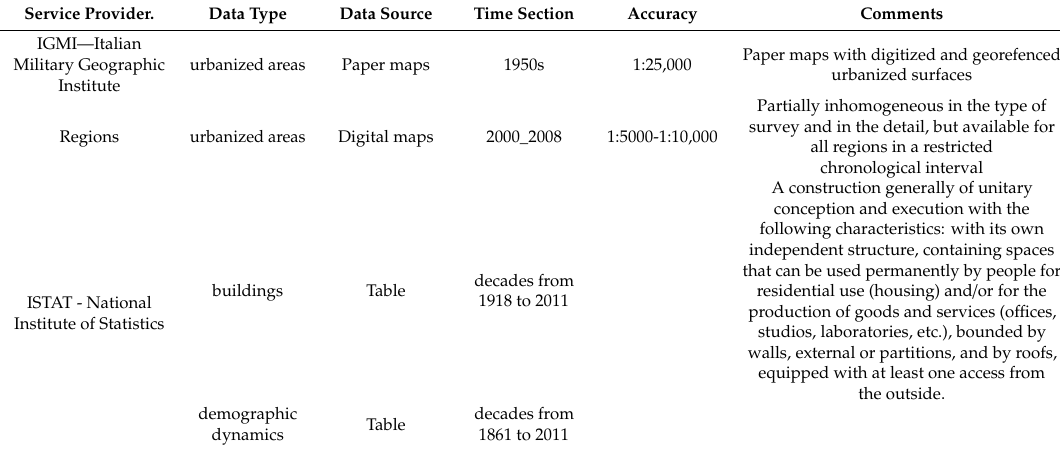
Table 1. Data used for